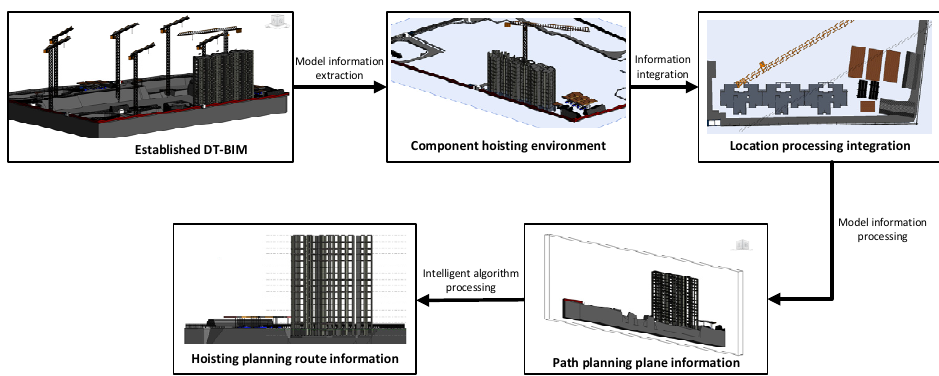
Figure 8. Hoisting planning plane obtained by model cutting.